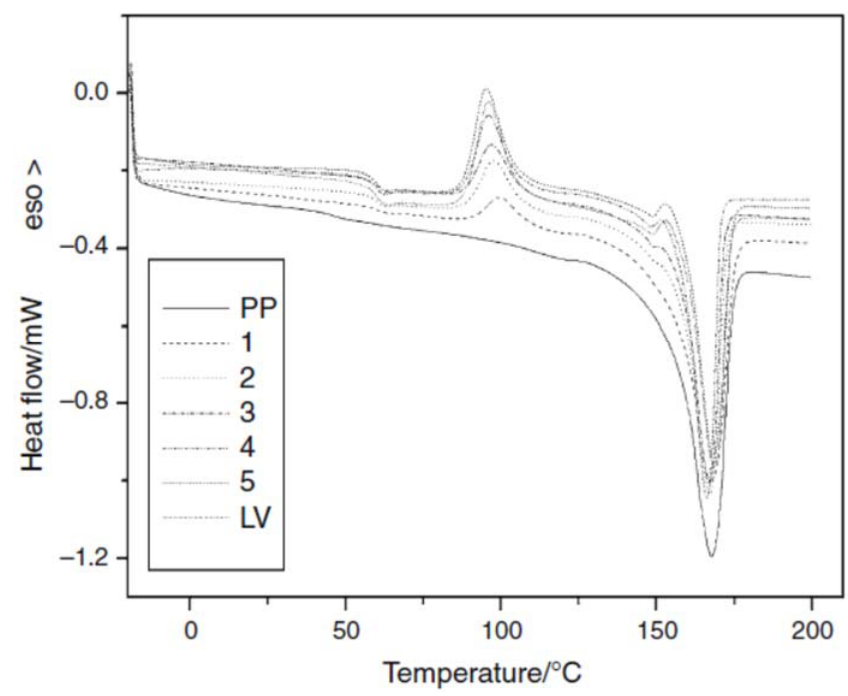
Figure 8. DSC curves, at 10°C min − 1 , of pure polypropylene (PP), liquid wood (LV) and PP blends at 20% (1), 40% (2), 50% (3), 60% (4), 80% (5) of LV. Reprinted from [41] with permission of Springer Nature.